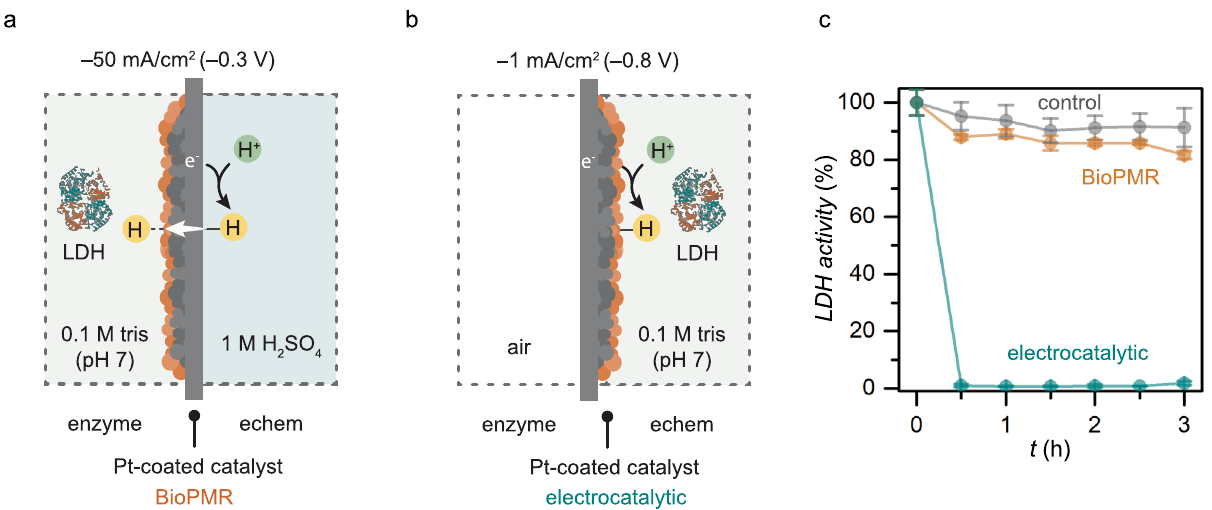
Fig. 5 | Enzyme stability for BioPMR and electrocatalytic regeneration condi- tions. Cell setup for a BioPMR regeneration conditions and b conventional elec- trocatalytic regeneration conditions. c LDH activity as a function of time for both